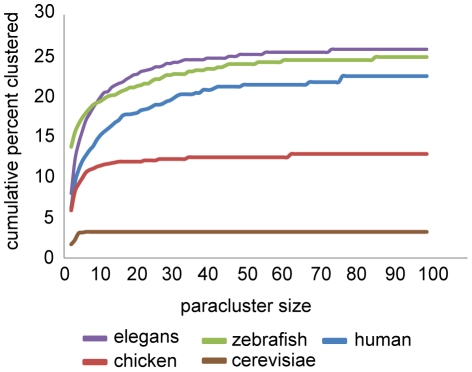
Species comparison of genome wide clustering metrics.Cumulative frequency distribution of the percentage of genes in paraclusters within the genomes of a selected set of species as a function of paracluster sizes.